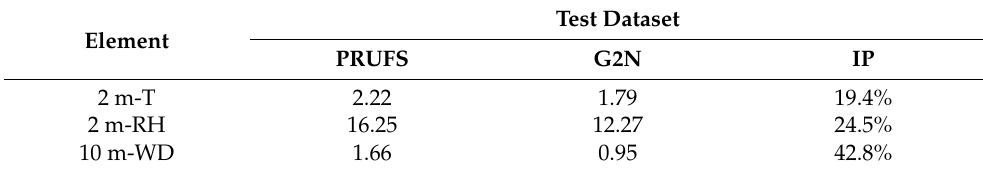
Table 1. The RMSE and improvement percentages (IP) (see Equation (6)) of the 2 m temperature, 2 m relative humidity, and 10 m wind speed 0–24 h forecasts corrected by G2N, averaged at all stations.